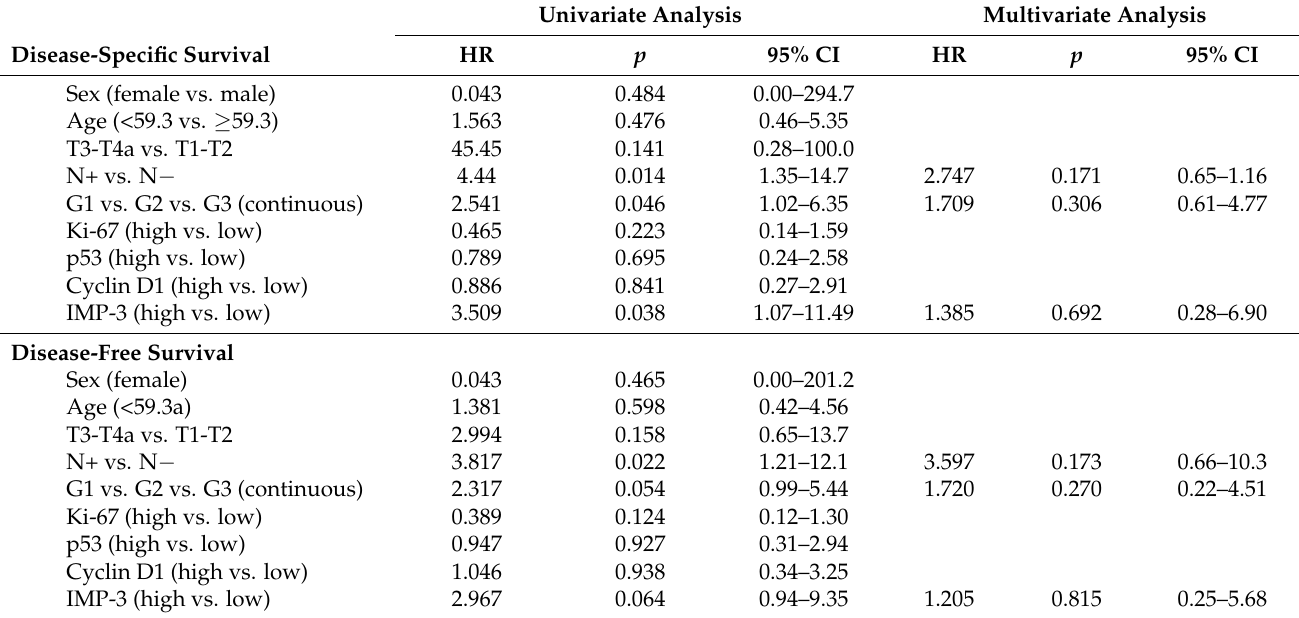
Figure 3. Survival curves: Kaplan–Meier plots illustrating a trend toward shorter disease-free survival in patients with high IMP3 expression ( A ) and a significantly worse disease-specific survival (DSS) ( B ). Table 5. Cox regression analysis.